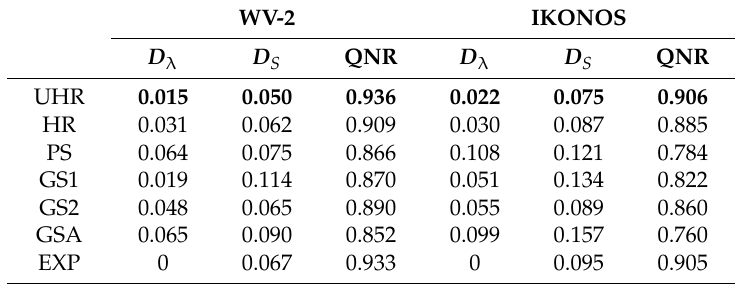
Table 2. Values of the comprehensive quality indices of the fused images produced from the original WV-2 and IKONOS datasets. QNR, Quality index with no reference images. WV-2